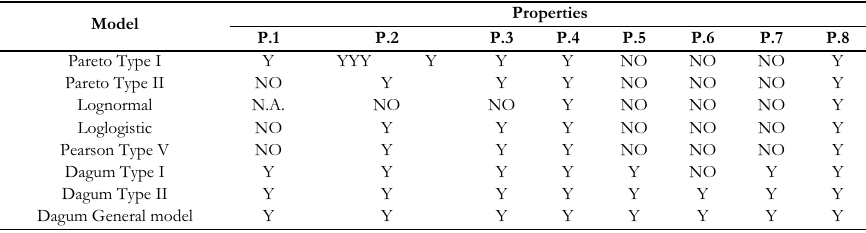
Wealth distribution models and their properties